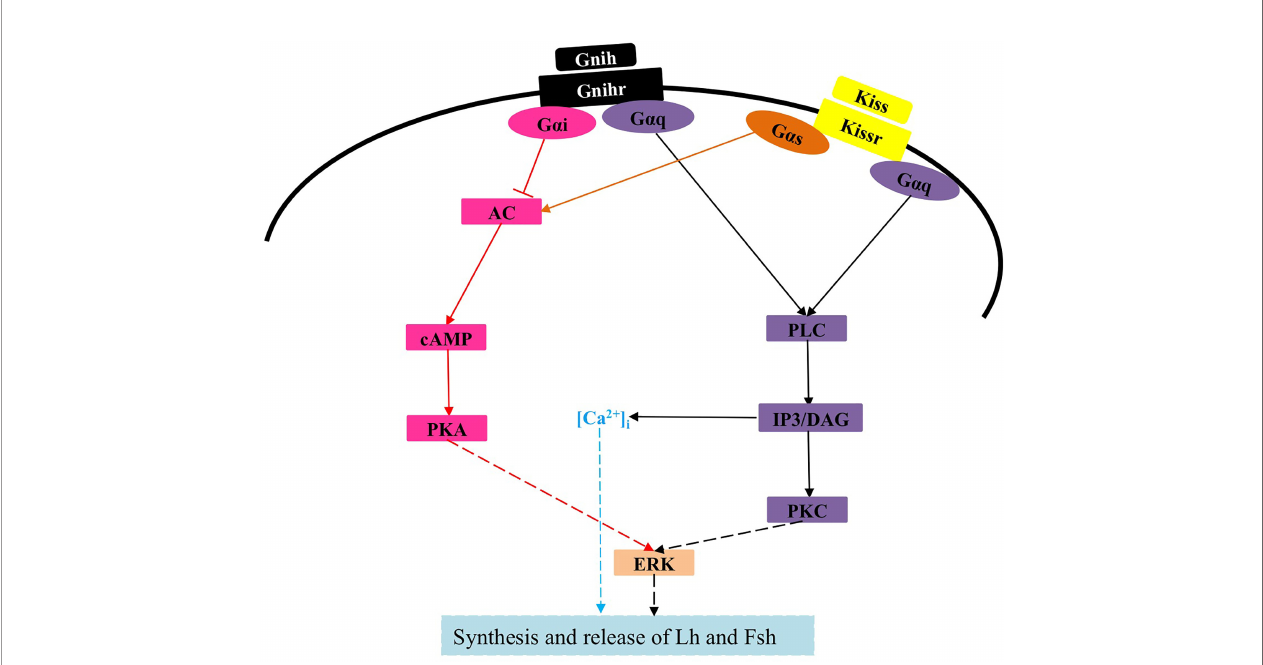
FIGURE 3 | Signaling pathway of Kissr and possible interaction with Gnih in teleosts. The solid lines represent con fi rmed effects, whereas the dashed lines indicate very limited evidence or possible pathways and interactions that merit further investigation. Kiss, kisspeptin; Kissr, Kiss receptor; Gnih, gonadotropin-inhibitory hormone; Gnihr, Gnih receptor; G a q, G a s and G a i, heterotrimeric G proteins; PLC, phospholipase C; IP3, inositol 1,4,5-trisphosphate; DAG, diacylglycerol; PKC, protein kinase C; ERK, extracellular signal-regulated kinase; AC, adenylyl cyclase; PKA, protein kinase A; Lh, luteinizing hormone; Fsh, follicle-stimulating